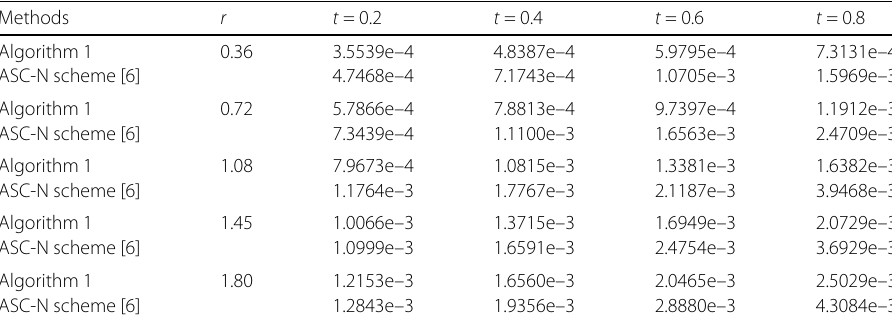
Table 4 Comparisons by the maximum errors to Example 1 for h = 1/19 (i.e., m – 1 = 18 = 6 K , K =